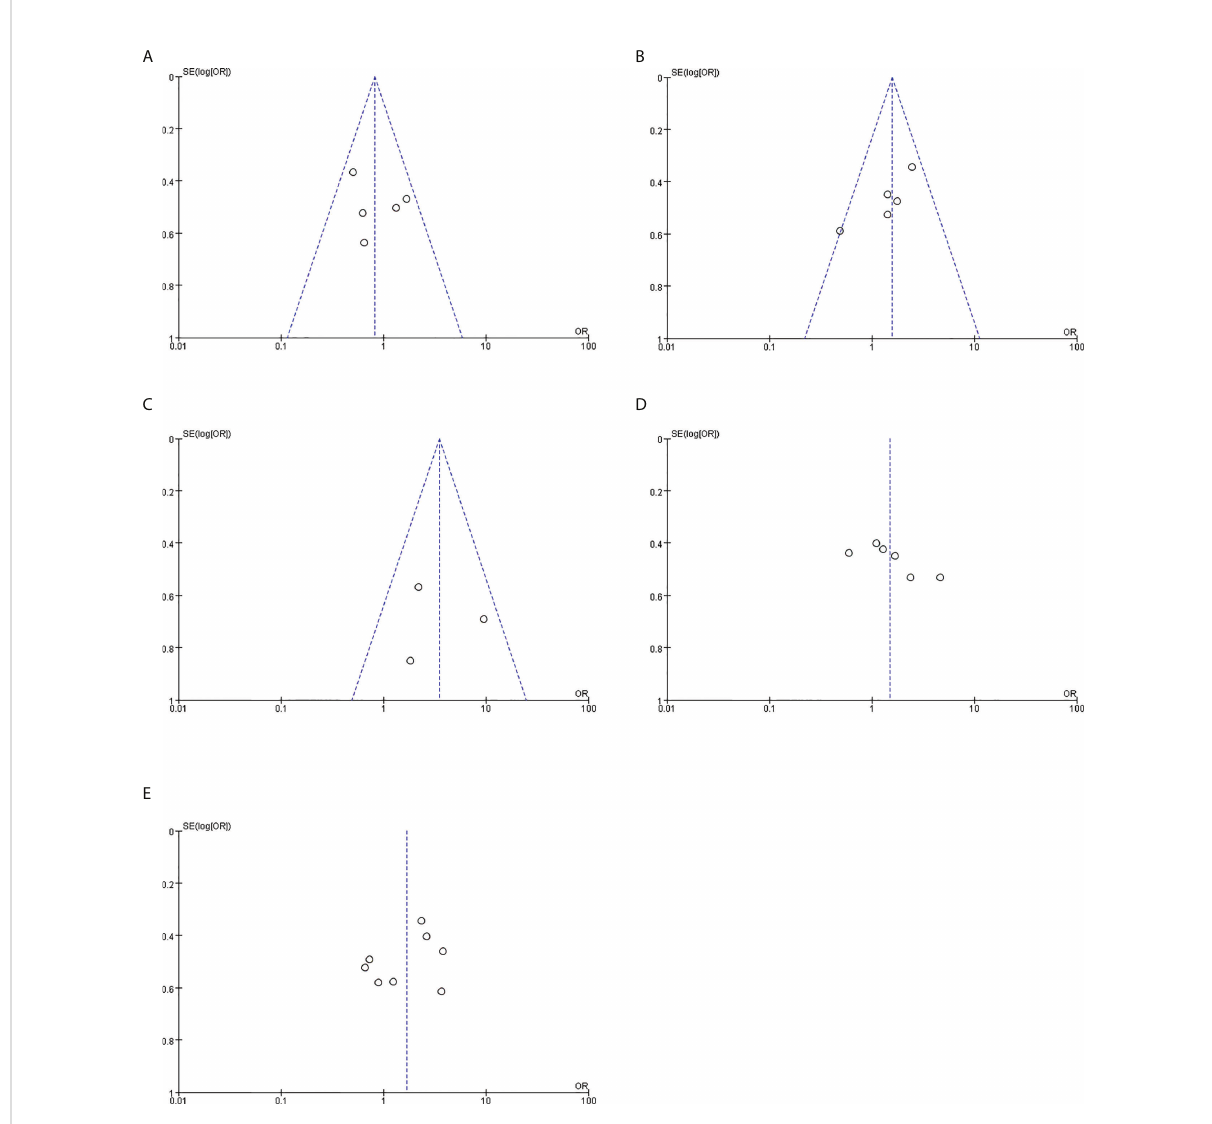
FIGURE 7 Publication bias. (A) Relationship between PYCR1 expression and cancer differentiation. (B) Relationship between PYCR1 expression and cancer lymph node metastasis. (C) Relationship between PYCR1 expression and distant metastasis of cancer. (D) Relationship between PYCR1 expression and cancer size. (E) PYCR1 expression and clinical stage of cancer